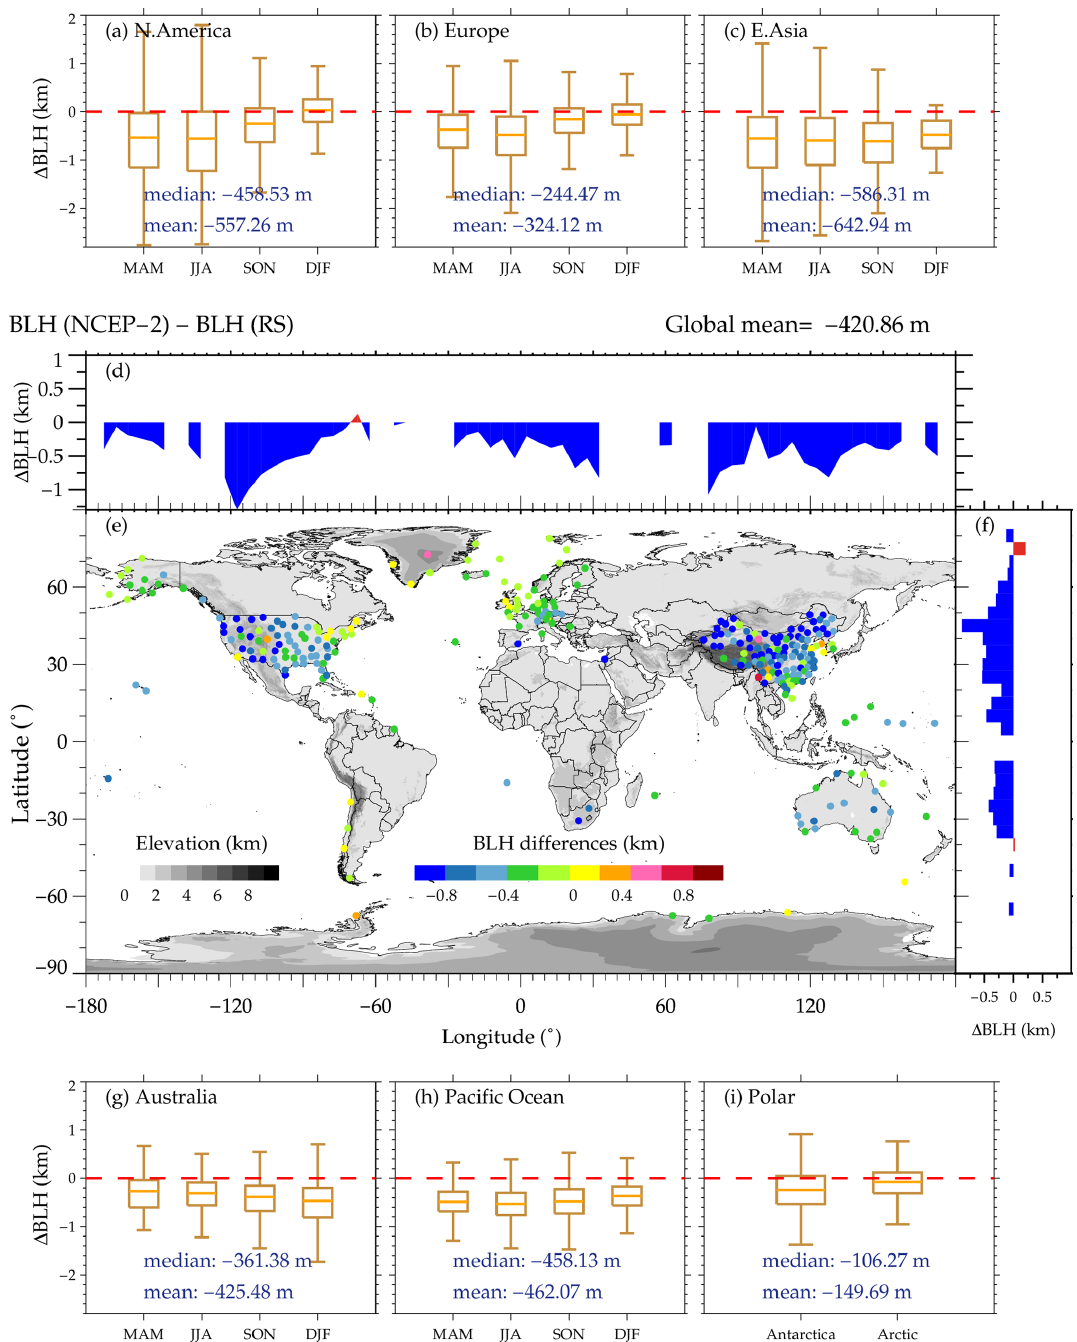
Figure 10. Similar to Fig. 7 but for the differences between NCEP-2-derived BLHs and radiosonde-determined BLHs.